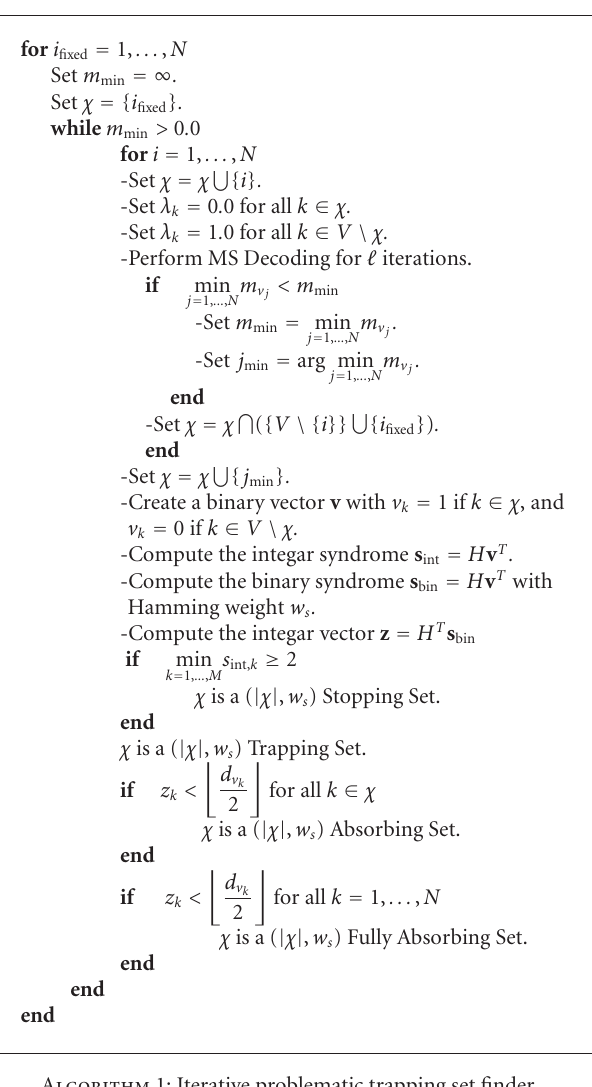
Algorithm 1: Iterative problematic trapping set